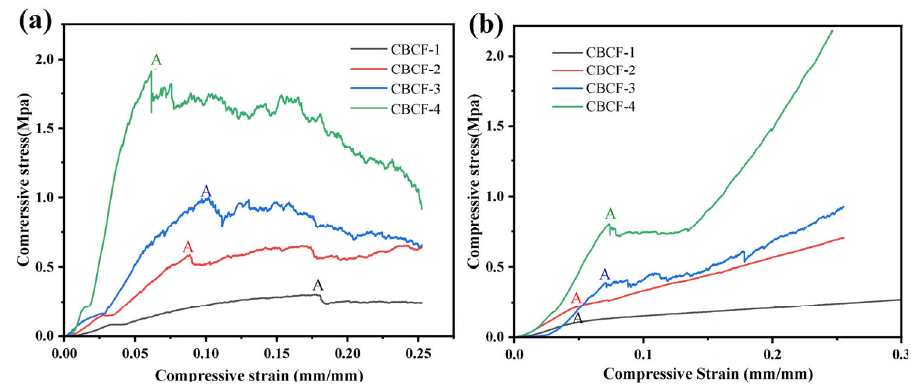
Figure 6. ( a ) XY direction and ( b ) Z direction stress–strain curves of CBCF ‐ 1, CBCF ‐ 2, CBCF ‐ 3, and CBCF ‐ 4.